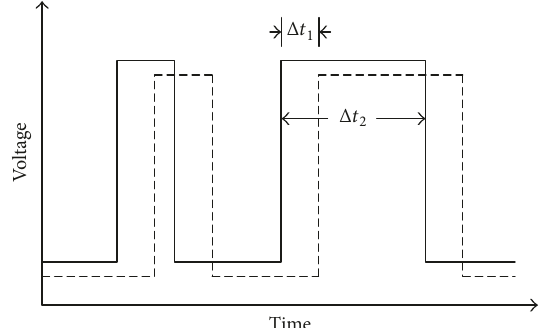
Figure 3: Time lag between the output signals of a double-tip